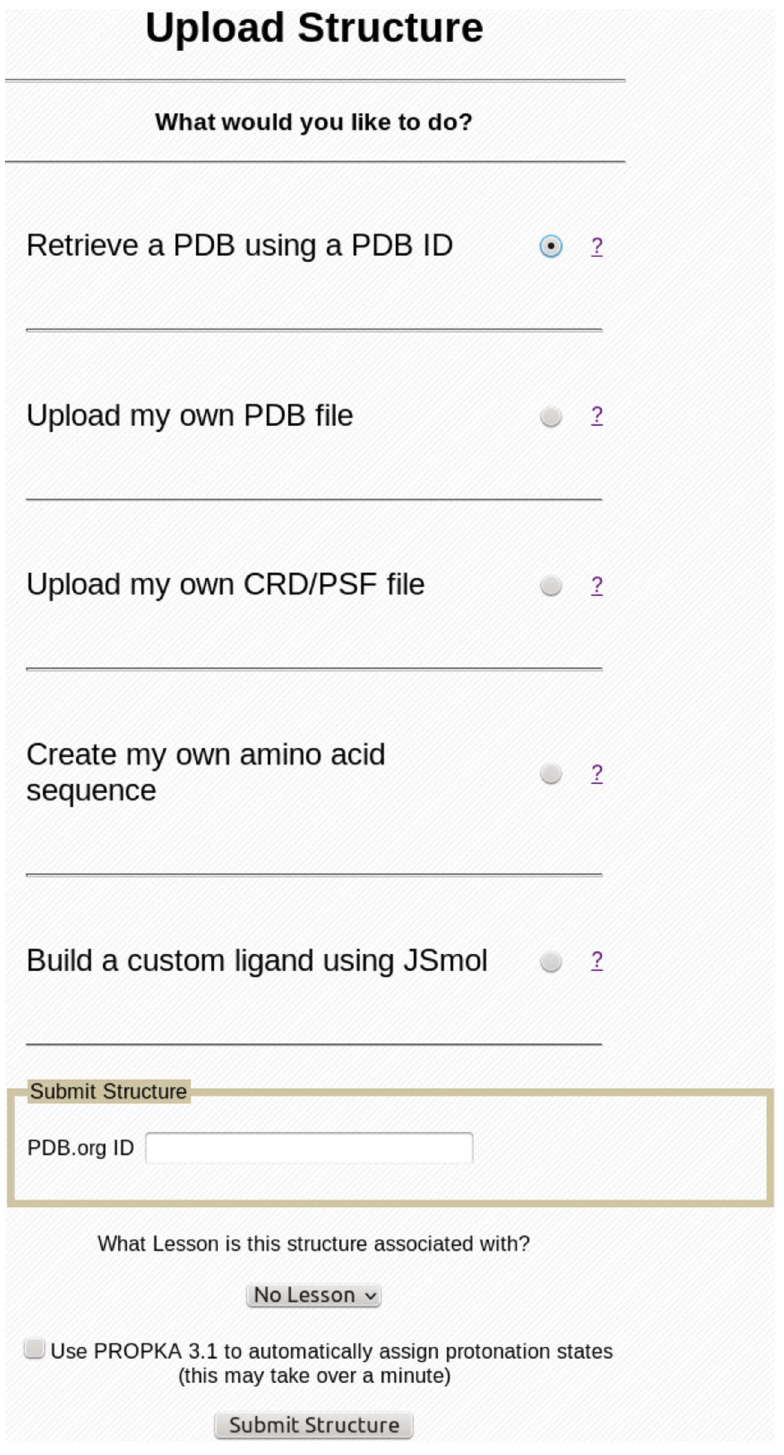
Figure 1. The file upload page of CHARMMing version 0.10. A drop-down menu allowing the user to select a lesson that the new structure is to be used for has been